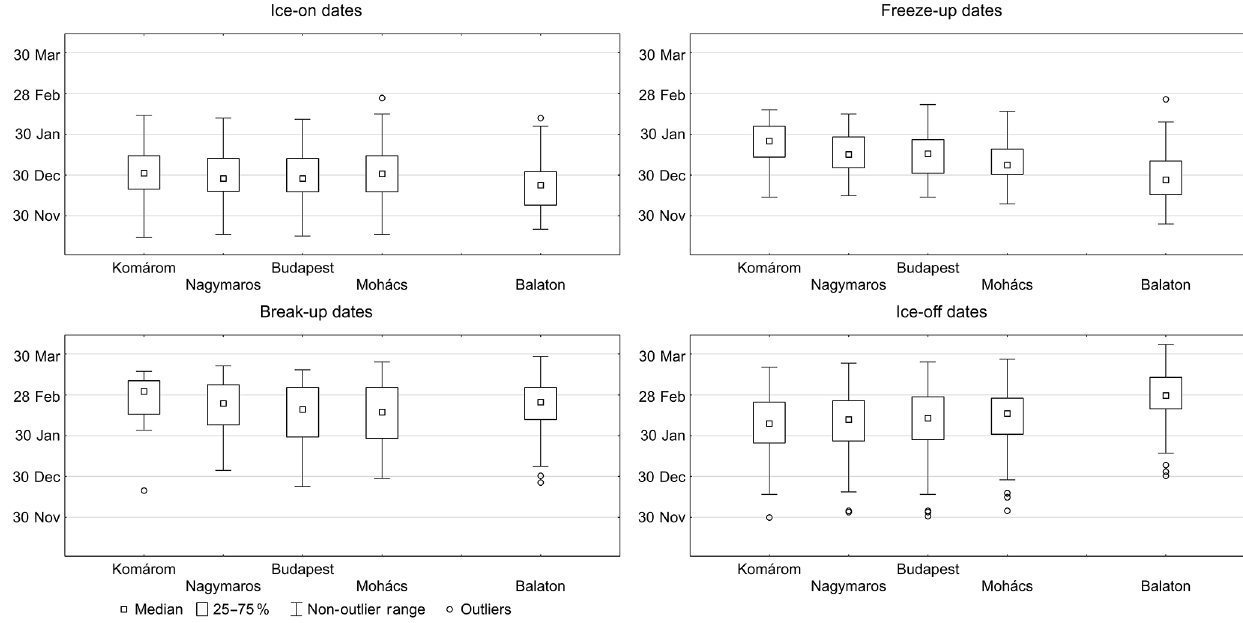
Figure 2. Basic characteristics of the ice regime of the River Danube and Lake Balaton from 1885 to 2017.